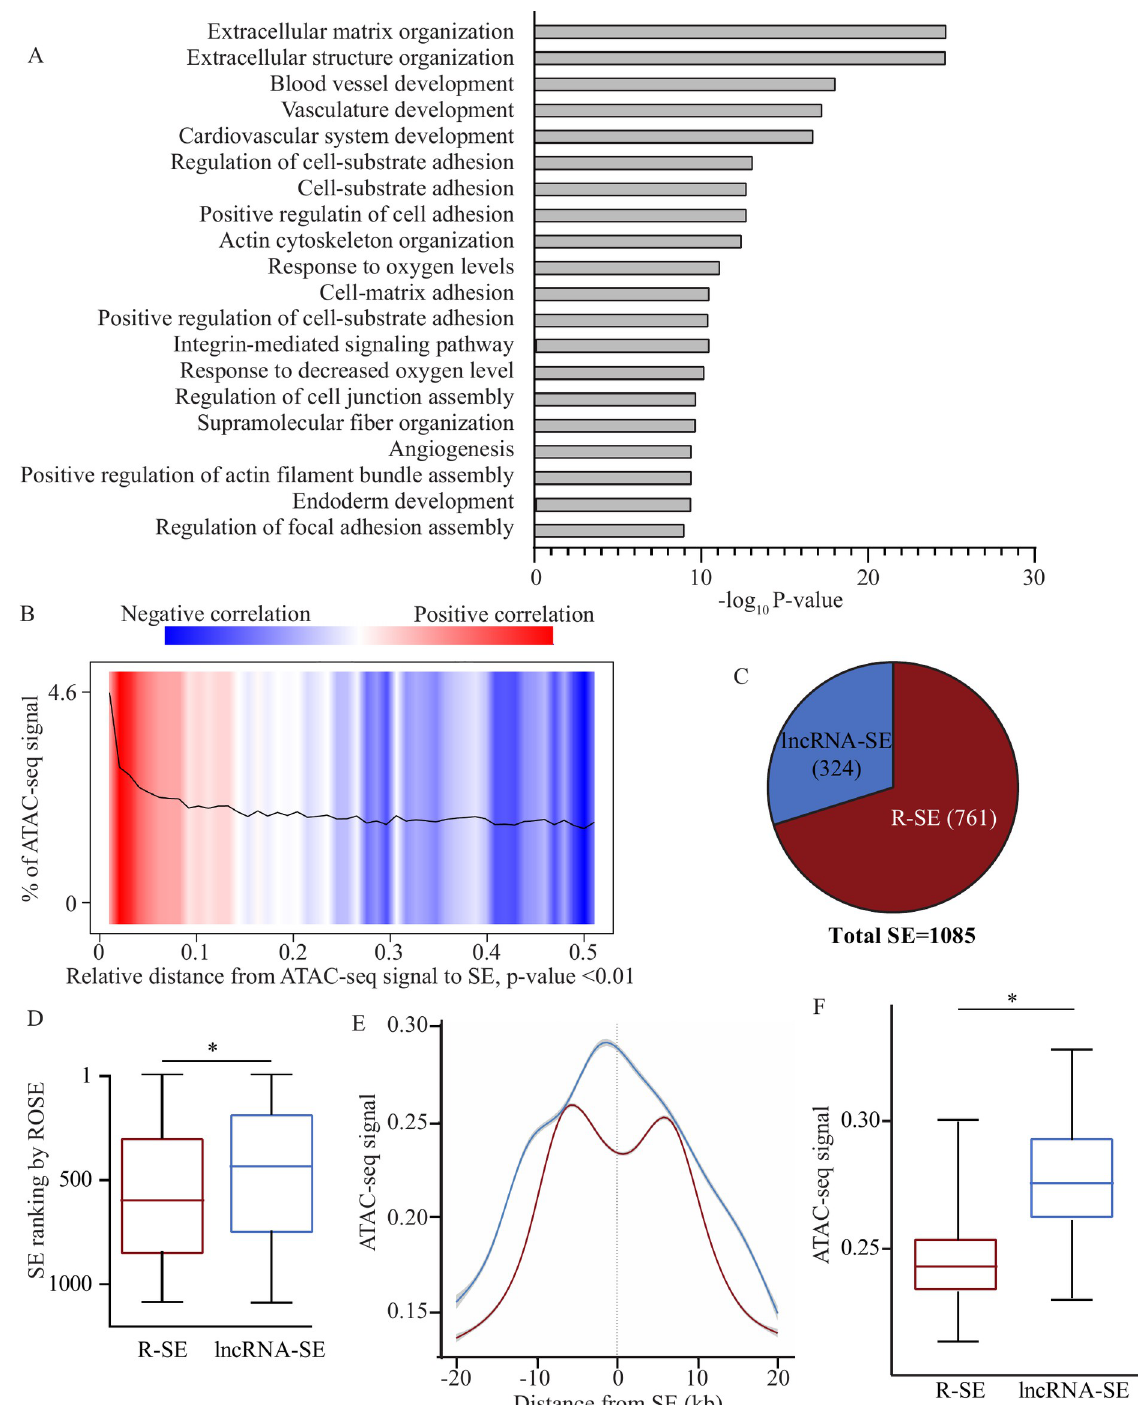
Fig 1. Super-enhancer (SE) in valve interstitial cells (VICs). A) Gene ontology enrichment for SE in VICs (adjusted P-value). B) ATAC-seq signal relative to distance from SE. C) Pie chart showing that 30% of VICs SE intersect with lncRNA (lncRNA-SE); SEs for which no lncRNA is transcribed are defined as regular SE (R-SE). D) The ranking of super-enhancer (ROSE) algorithm indicates that lncRNA-SE rank higher than R-SE in VICs. E) Signal intensity for open chromatin (ATAC-seq) was higher at the core of lncRNA-SE compared with R-SE. F) Box plot revealing higher ATAC-seq signal for